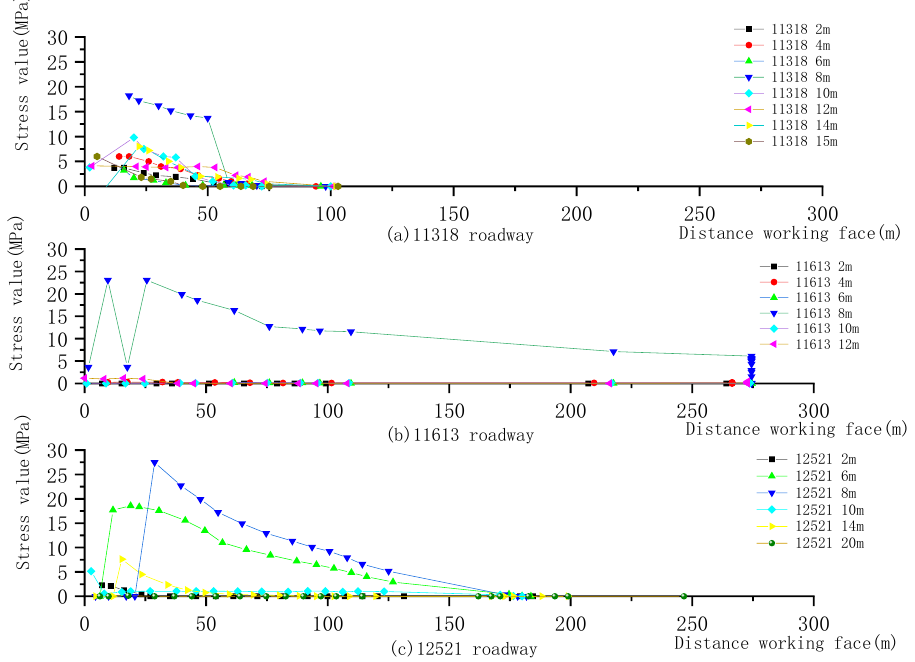
Figure 11. Comparison analysis diagram of vertical stress increment at different depth measuring points in low wall. ( a ) 11318 roadway; ( b ) 11613 roadway; ( c ) 12521 roadway.